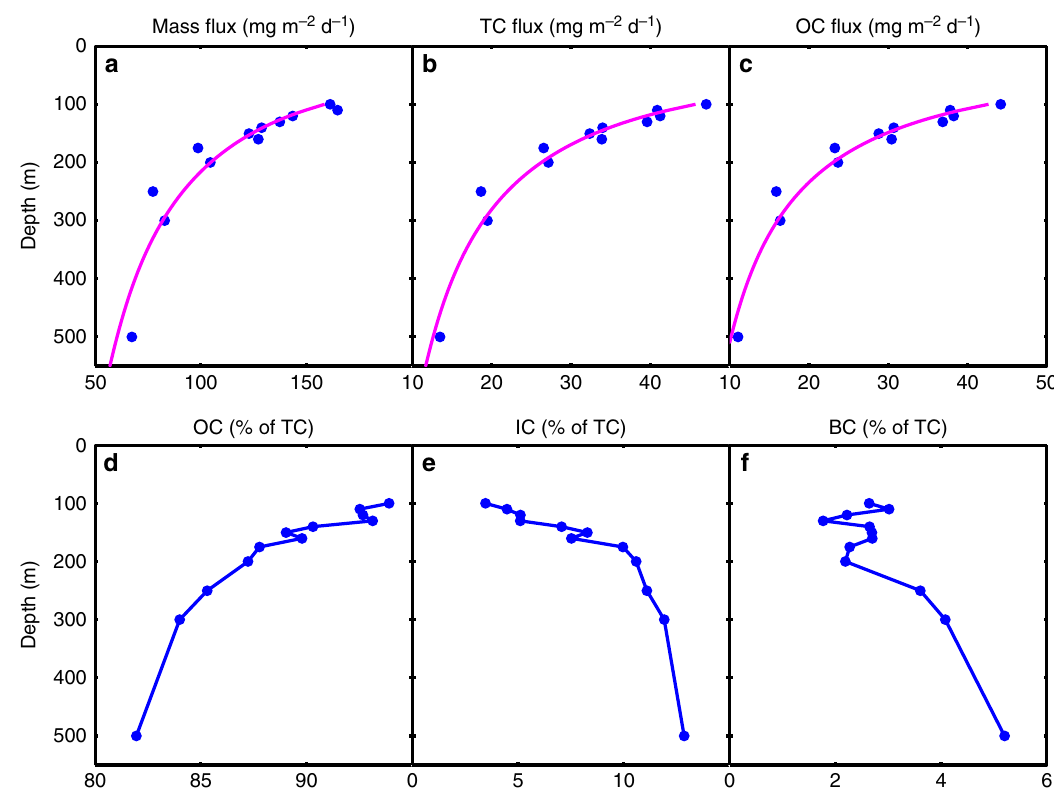
Fig. 1 Mass and carbon fl uxes. Flux pro fi les of a mass, b total carbon (TC), and c organic carbon (OC). The magenta curves are the best fi ts to a log – log transformed normalized power function of the form F z = F 100 ( z /100) b where F z is fl ux at depth z (m), F 100 is fl ux at 100 m and b is the coef fi cient of fl ux attenuation (ref. 11 ; Supplementary Fig. 1). The best fi t parameters are: mass fl ux, F 100 = 158.5 mg m − 2 d − 1 , b = − 0.60, r 2 = 0.85; TC fl ux, F 100 = 45.71mg C m − 2 d − 1 , b = − 0.80, r 2 = 0.93; OC fl ux, F 100 = 42.66 mg C m − 2 d − 1 , b = − 0.89, r 2 = 0.93. Vertical fl uxes of d OC, e IC and f BC expressed as percentages of TC for each Table 1 Total mass and elemental fl uxes of sinking particulate matter Sediment trap depth